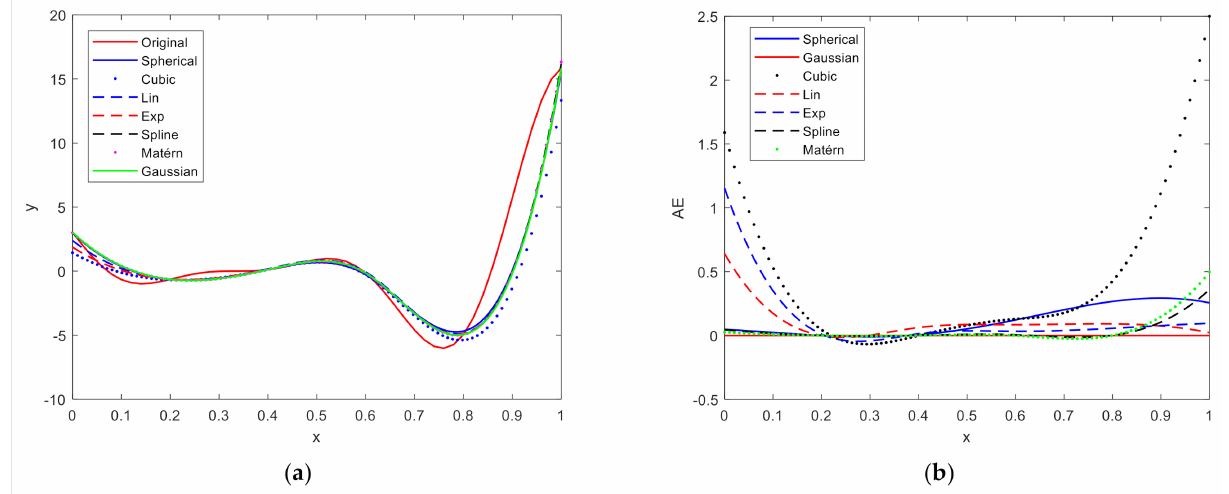
Figure 1. ( a ) Kriging approximate function based on different correlation functions; ( b ) absolute error (AE) of Kriging approximation